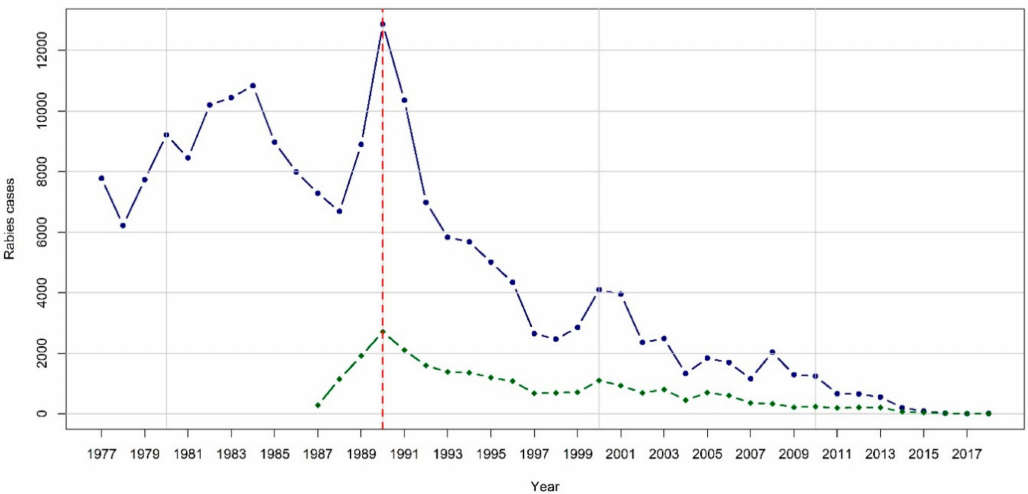
Figure 2. Evolution of fox cases in the 28 EU countries (data source: Rabies Bulletin Europe, Rabies Information System of the WHO Collaboration Centre for Rabies Surveillance and Research; http: // www.who-rabies-bulletin.org / Queries / Default.Aspx). Red dashed line: 1989, start of European Commission co-funding and large scale ORV programs; Blue line: fox cases; Green line: domestic cases.